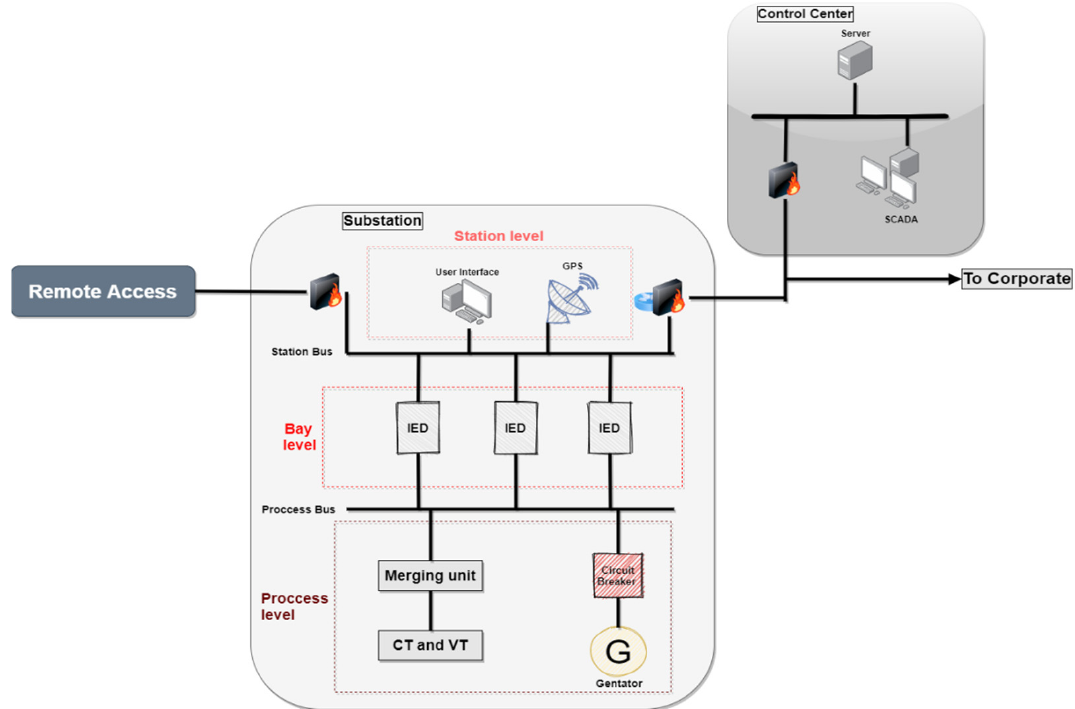
Figure 1. System model representing smart grid substation.